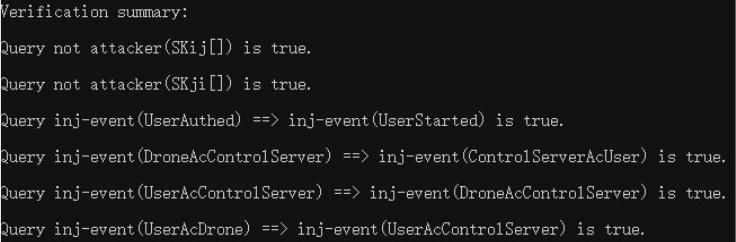
Figure 10. ProVerif